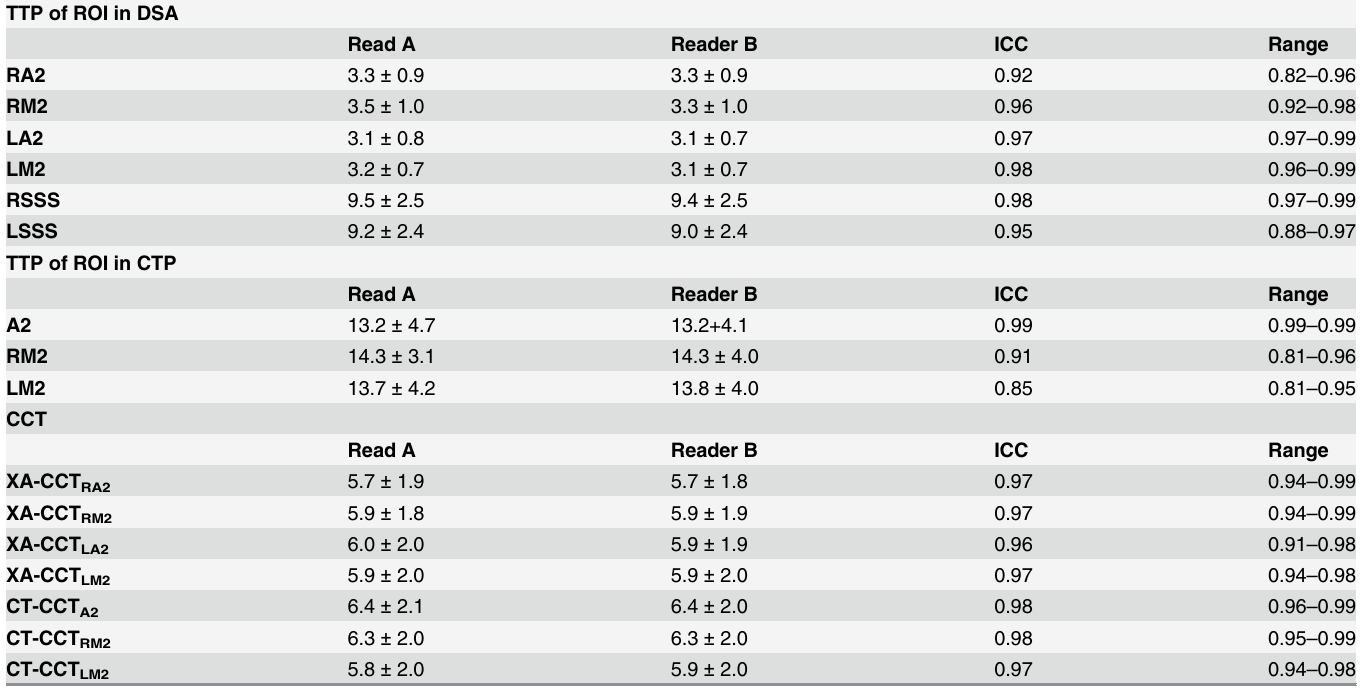
Table 2. Intraclass-classification of Tmax in selected ROIs in DSA, TTP of selected ROIs in CTP, and calculated CCT. TTP of ROI in DSA Read